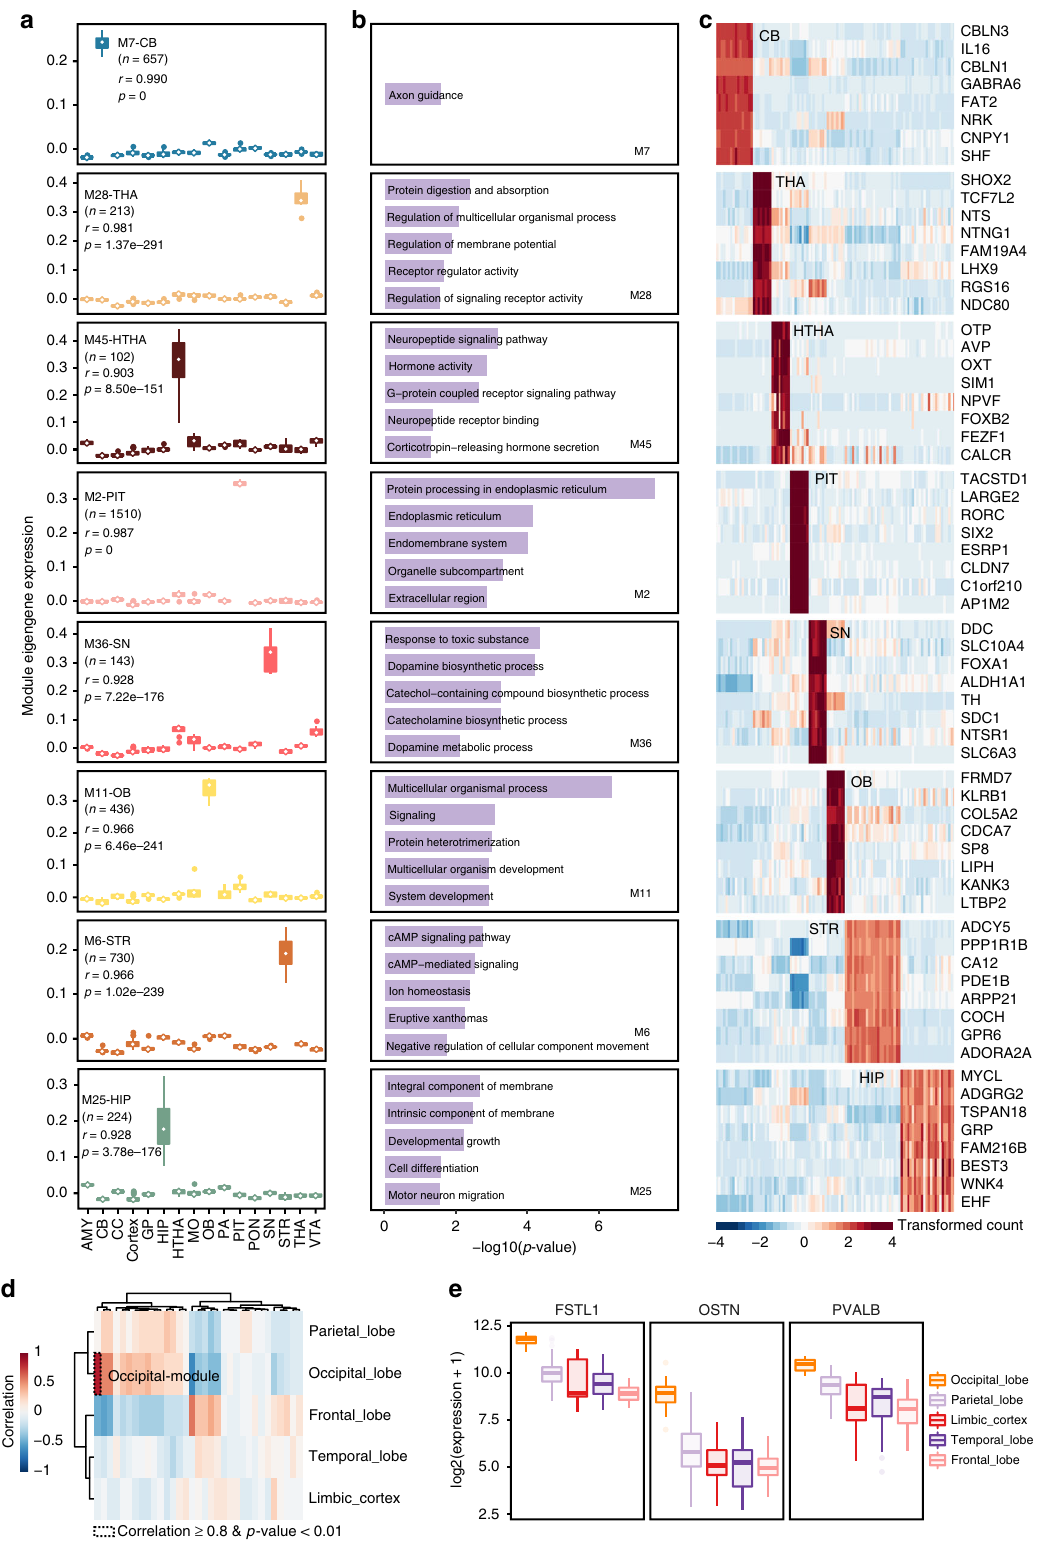
−1−0.500.51 Correlation ≥ 0.8 & p -value < 0.01 Fig. 3 Region-related gene modules. a Boxplot showing expression of the module eigengenes for each of the region-related gene modules. The modules were highly correlated to speci fi c regions (Pearson ’ s r > 0.9, p -value < 0.01). The parenthesized number represented number of genes in each module. b Enriched GO-terms of the corresponding gene modules. c Expression heatmap of the top genes in each of the region-related gene module, scaled by row. d Heatmap showing correlation between brain lobes and gene modules discovered in cerebral cortex samples. e Boxplot depicting expression of top marker genes in occipital lobe-associated gene module (occipital module). In boxplots, center line, box edges and whiskers indicate the median, upper and lower quartiles (the 25th and 75th percentiles) and 1.5 × interquartile range, respectively. The colors represented lobe of